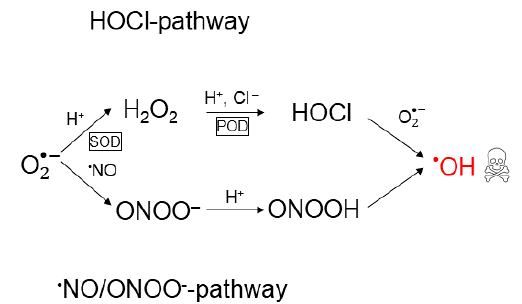
Figure 1. Schematic illustration of the reaction network of apoptosis-inducing signaling pathways: the hypochlorous acid- and the nitric oxide/peroxynitrite pathway. Both pathways originate from superoxide anions and result in the formation of hydroxyl radicals, which are responsible for apoptosis-induction.